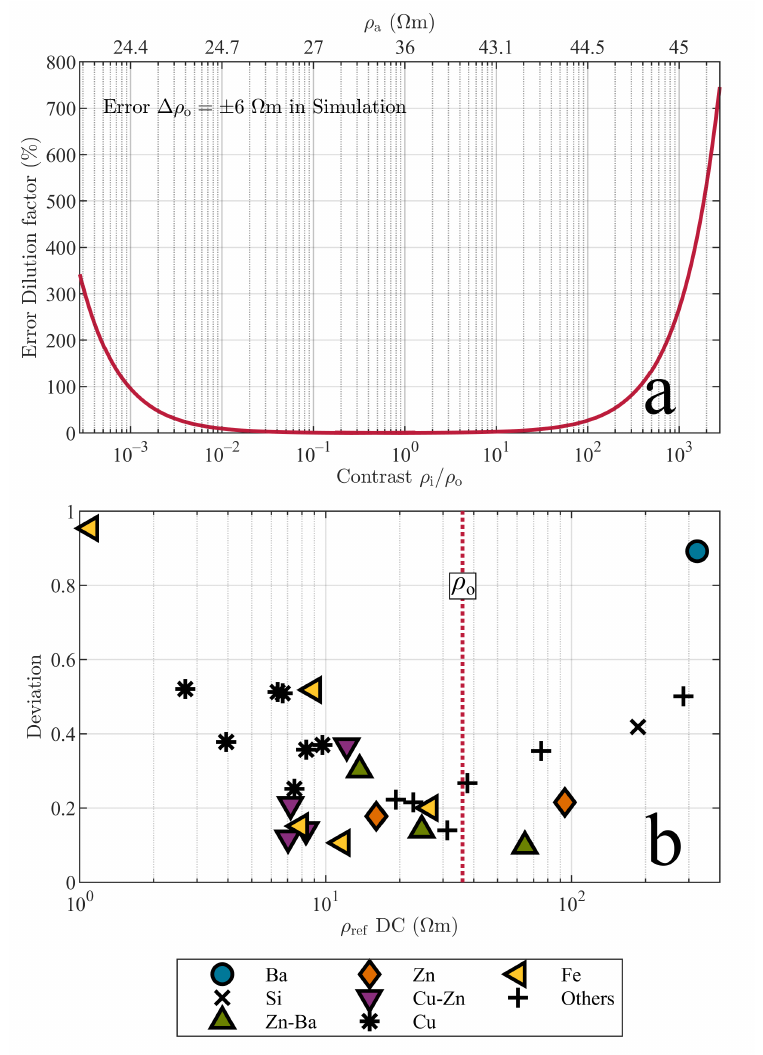
Figure 11. ( a ) The error caused in the dilution factor by an error of 6 Ω m in the assumption of the outer medium resistivity vs. resistivity contrast, obtained from numerical simulation. All other parameters are the same as those used in Figure 4. The horizontal scale at the top is the bulk resistivity corresponding to the resistivity contrast. ( b ) The RMS deviation of the estimated phase shift calculated with the dilution factor obtained by simulation vs. DC resistivity of the target. The red dotted line indicates the assumed value of the outer medium resistivity ρ o = 36 Ω